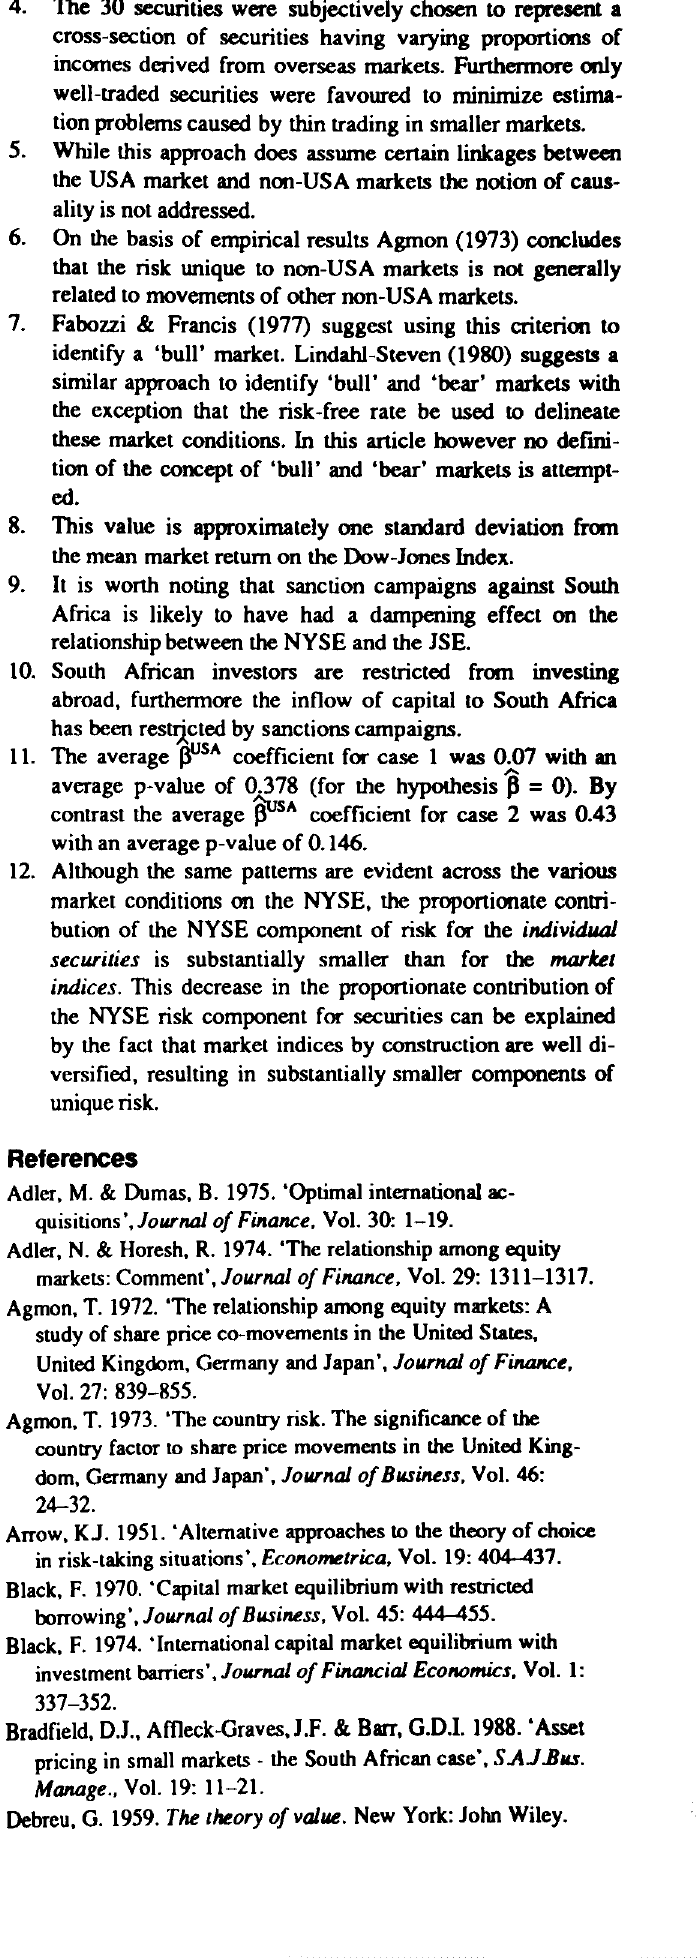
Table 3 Average risk components of shares with signi ficant ~usA coefficients expressed as a percentage of total